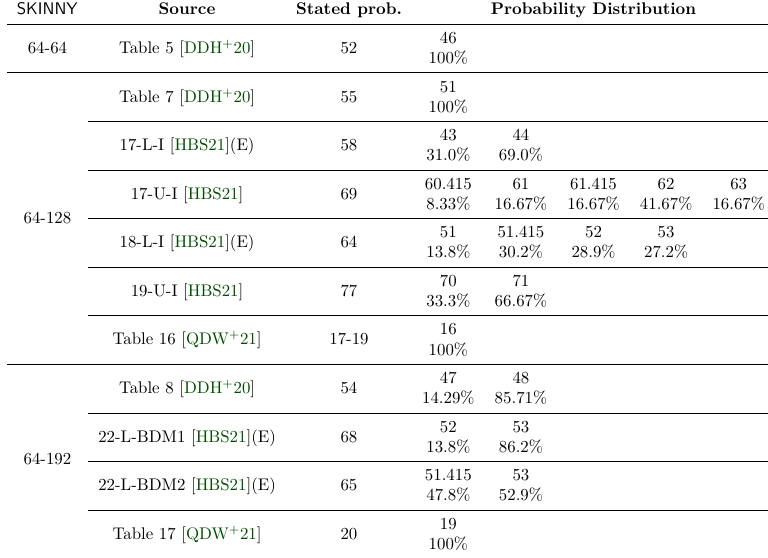
Table 6: The probability distribution estimation for each differential characteristic from Table 1. “Stated prob.” refers to the − log The first row in each probability distribution refers to the probability (in − log percentage of keys having this probability shown below